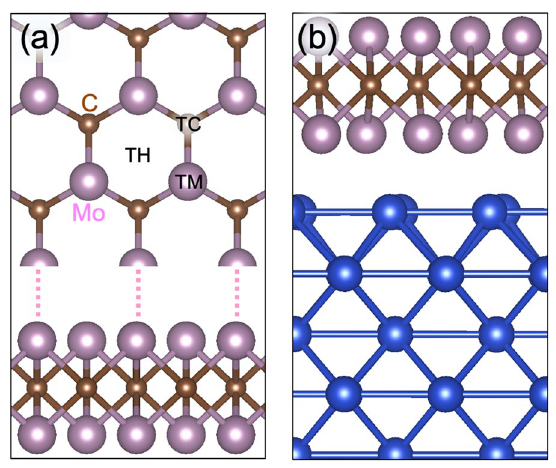
Figure 1. Atomic structures of ( a ) Mo 2 C and ( b ) Mo 2 C on a metal substrate. The pink, brown, and blue balls represent Mo, C, and substrate atoms, respectively. In ( a ), hydrogen absorption sites are denoted by TH, TC, and TM, which are on-top of a hexagonal center, C atom, and Mo atom, respectively.